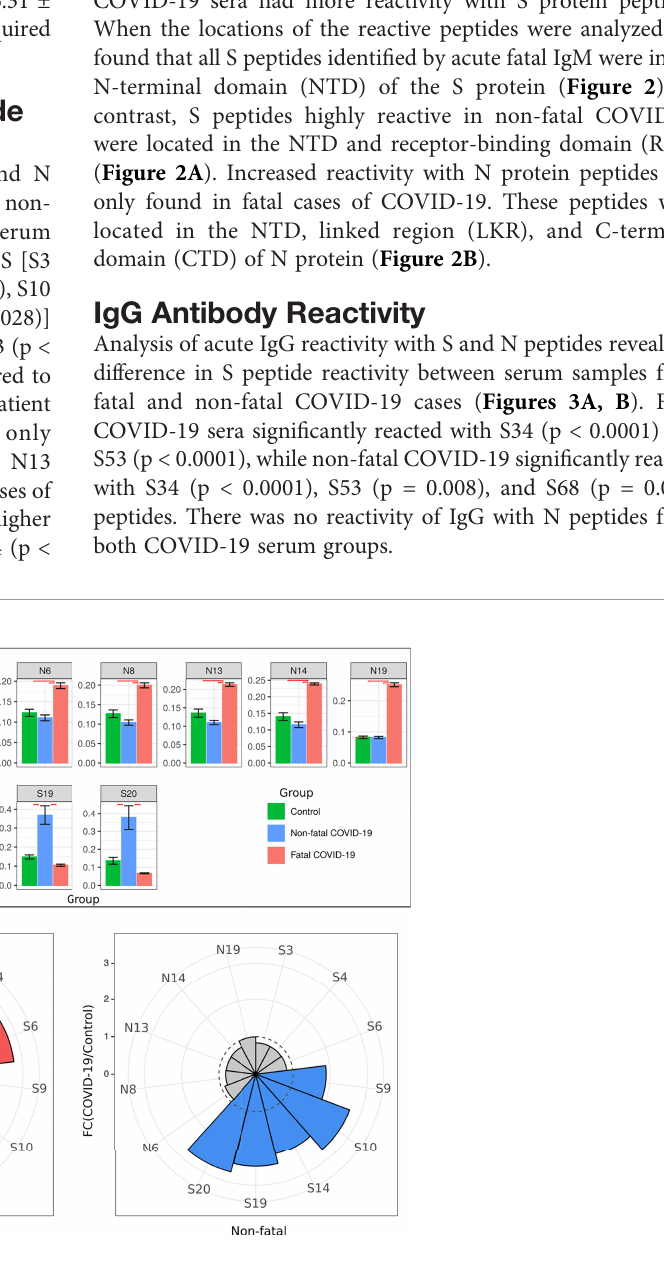
FIGURE 1 | Serum IgM reactivity with S and N SARS-CoV-2 peptide in non-fatal and fatal COVID-19. Serum from acute COVID-19 was used to determine IgM reactivity with SARS-CoV-2 S and N protein peptides using ELISA. (A) Bar graph of serum reactivity with SARS-CoV-2 S and N peptides in non-fatal and fatal COVID-19. Data is presented as mean±SEM (standard error of mean). Red brackets indicate statistically signi fi cant differences (p < 0.05, Kruskal-Wallis test with BH adjustment). (B) Nightingale rose plots demonstrating SARS-CoV-2 S and N peptides differentially reactive with serum from non-fatal and fatal COVID-19 cases. Red and blue – statistically signi fi cant reactivity between COVID-19 and control samples in fatal and non-fatal COVID-19 cases, respectively (p < 0.05, Kruskal-Wallis test with BH adjustment); Grey – reactivity does differ signi fi cantly between COVID-19 and control samples. Data is presented as fold change – mean value of reactivity to peptide in COVID-19 sera divided by mean of reactivity to the same peptides in control